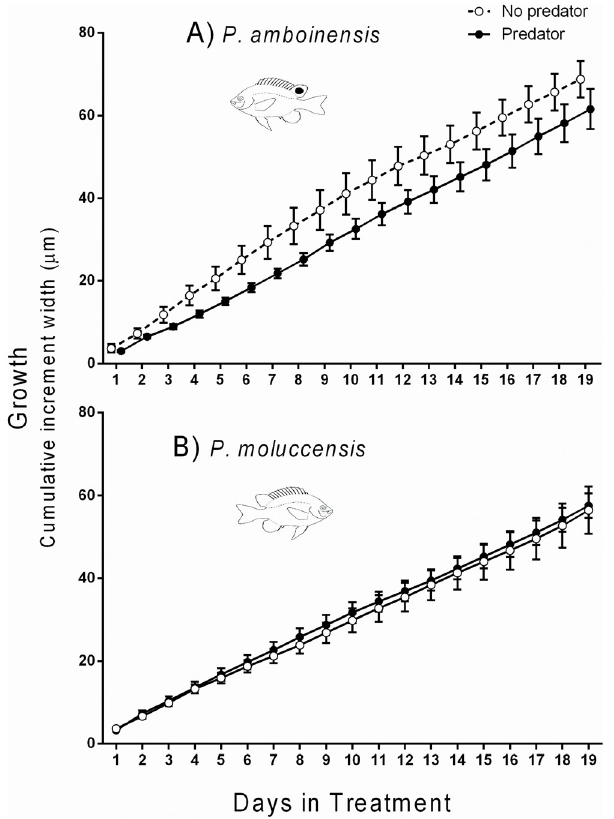
Fig 1. Growth (mean cumulative otolith increment width ± 1 SE) of A) P . amboinensis and B) P . moluccensis during the experimental period according to predator treatment. All data are for single fish (PA1 and PM1) only with no competitor